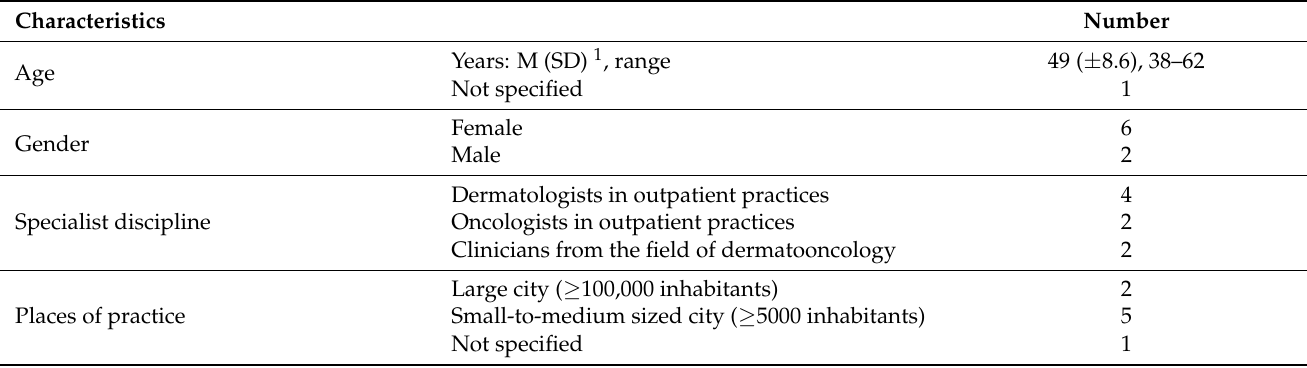
Table 2. Characteristics of physicians participating in the workshop (n =